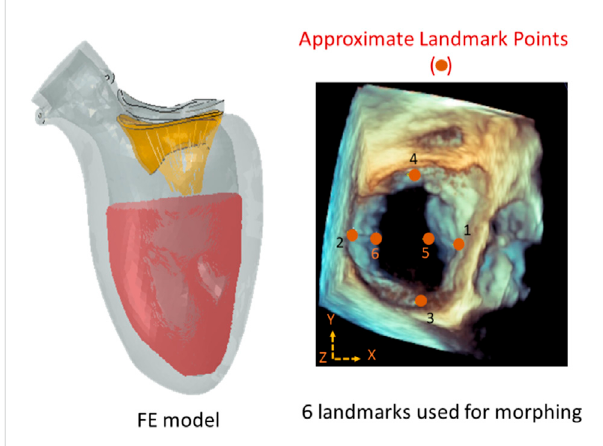
FIGURE 1 The approximate locations of the landmark points used during morphing (right), and the FE model (left). There were six locations along the lea fl et edges where the MC can be placed. The FE model included the mitral valve, the chords, the LV, and blood particles.